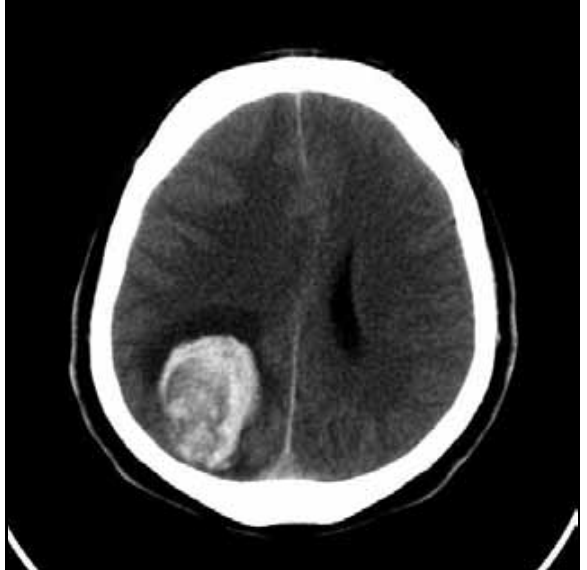
Figura 1 – Tomografia de crânio mostrando lesão intra-axial hiperdensa, bem delimi- tada em região occipital direita, associada ao edema do tecido nervoso